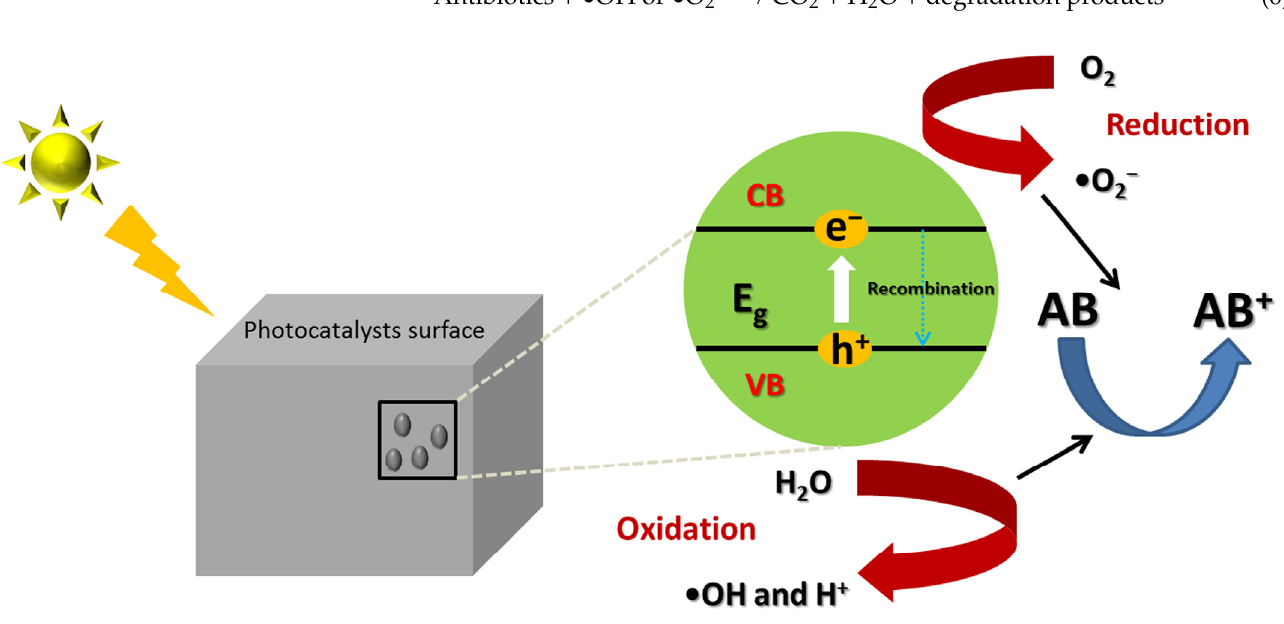
Figure 2. General photocatalytic mechanism on the degradation of antibiotics by the formation of photo-induced charge carriers (e − /h + ) on the photocatalysts’ surface.